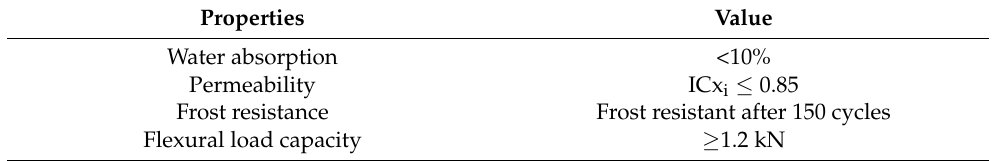
Table 2. Physical and mechanical properties of the new ceramic tiles produced with the old technology.